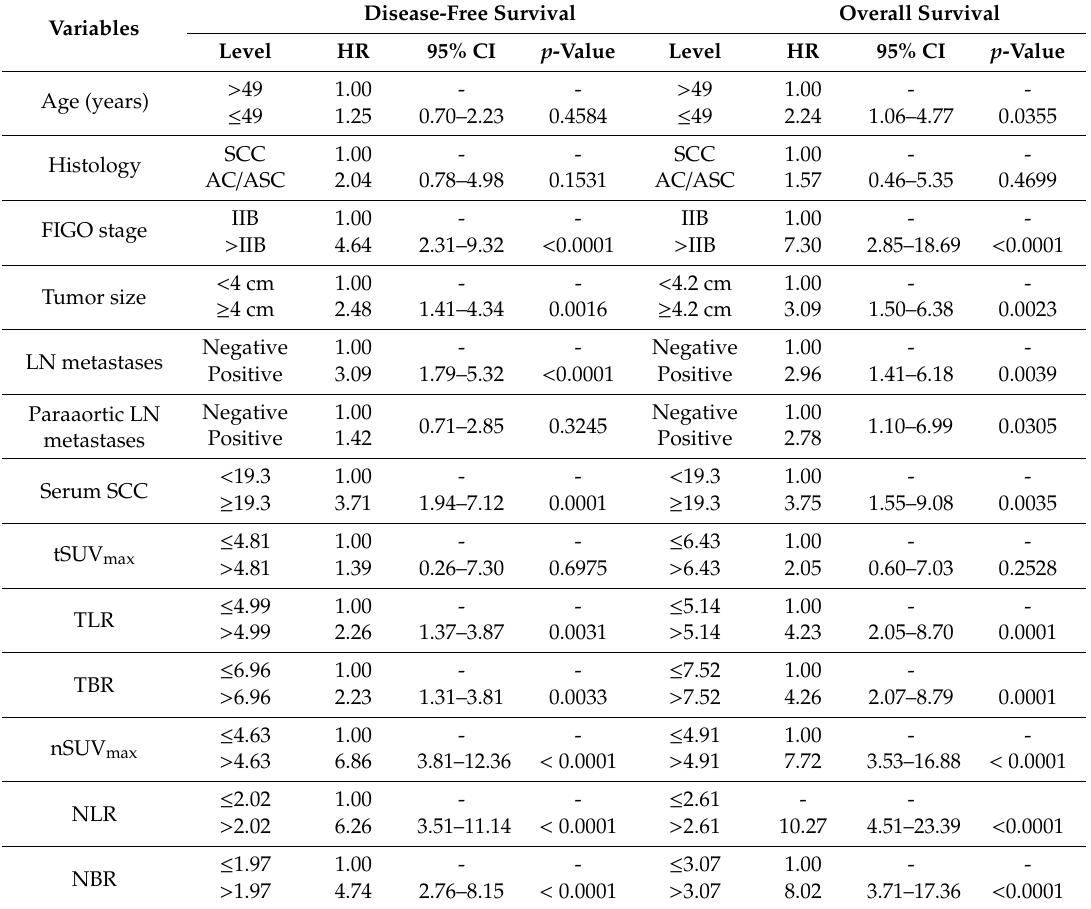
Table 2. Univariate analyses of clinical variable and quantitative metabolic parameters for DFS and